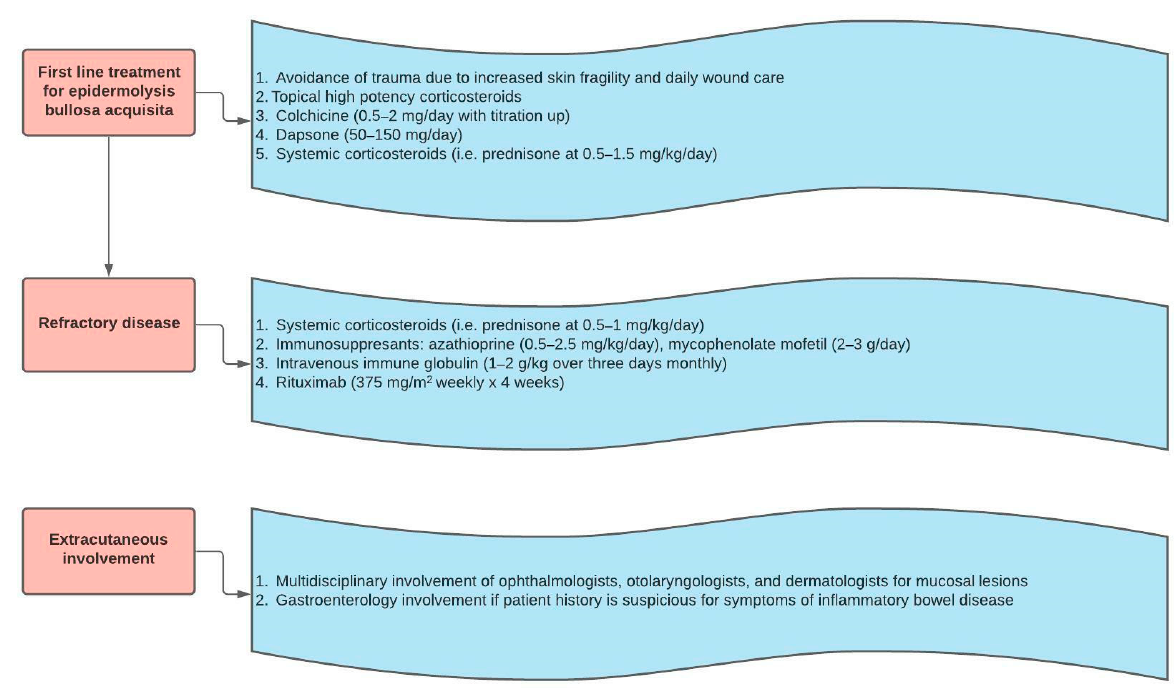
Figure 5. Epidermolysis bullosa acquisita treatment algorithm.